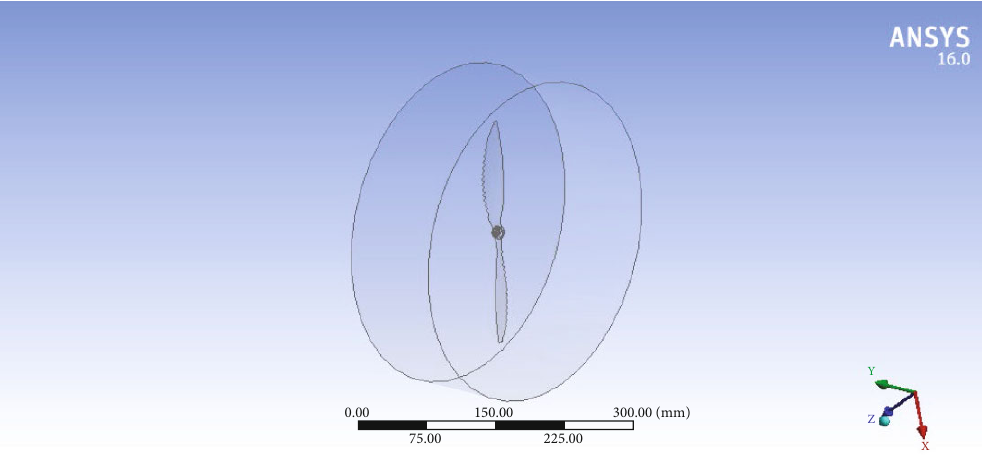
Figure 13: Rotation domain of